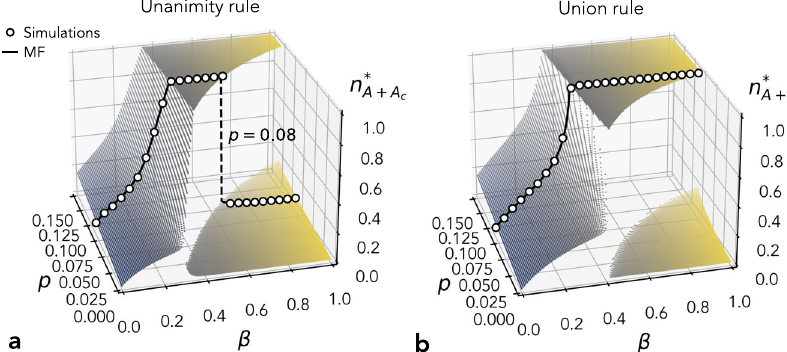
Fig. 5 Mean fi eld (MF) phase diagrams of the naming game with committed minorities on 2-uniform hypergraphs. Each three-dimensional surface (grey/yellow shading is only for visualisation purposes) gives the stationary fraction of agents supporting name A ( z -axis) as a function of the social in fl uence parameter β and of the fraction p of agents committed to A ( A c ). Different panels correspond to different conditions for group agreement, namely unanimity ( a ) and “ union" ( b ). The surfaces are obtained through numerical integration of Eq. (1) and Eq. (2) at fi xed p , β , with initial conditions n A (0) = 0, n B (0) = 1 − p , n AB (0) = 0. Example curves with p = 0.08 are shown with solid black lines. The associated results of stochastic simulations (circles) for homogeneous systems of 1000 agents are shown